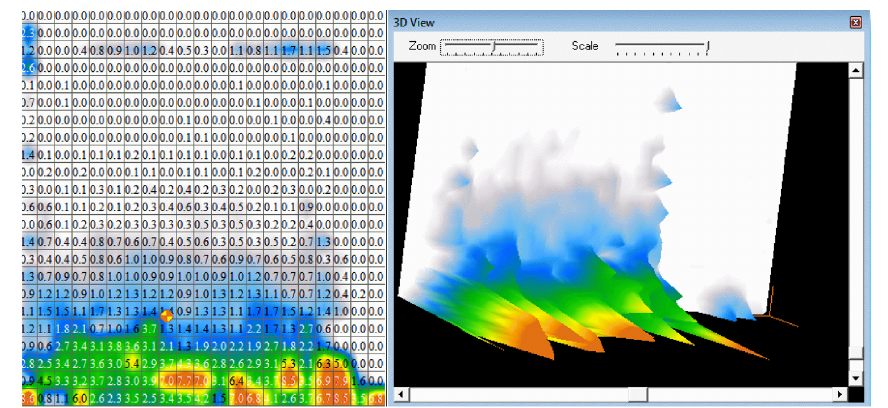
Figure 2. 2-D and 3-D impact representation registered by Tactilus ® pressure sensor.